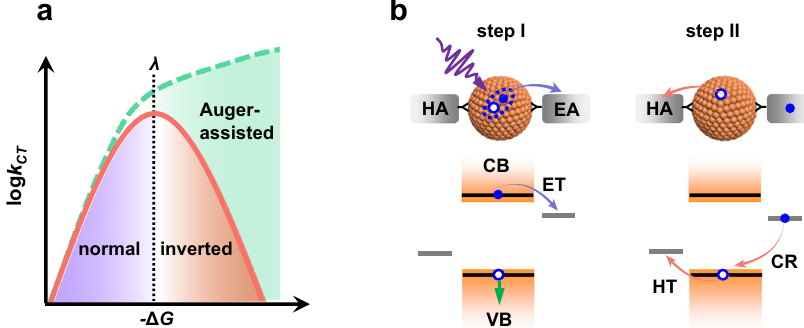
Fig. 1 Charge transfer (CT) models. a Marcus theory (red solid line) predicts a normal region (blue shading) and an inverted region (red shading) when the driving force ( − Δ G ) is smaller and larger, respectively, than the reorganization energy ( λ ), whereas the Auger-assisted CT model (green dashed line) exhibits a monotonic increase of CT rate ( k CT ) because the excessive driving force can be used to excite another Coulomb-couple charge. b For a photoexcited QD attached with electron (EA) and hole acceptors (HA), the fi rst CT event (e.g., ET electron transfer) was proposed to occur via the Auger- assisted model (step I). In contrast, in step II, the second CT (e.g., HT hole transfer) obeys Marcus theory as it is not coupled any other charges, so does the energy-wasting charge recombination (CR) process. HT and CR are parallel, competing processes in step